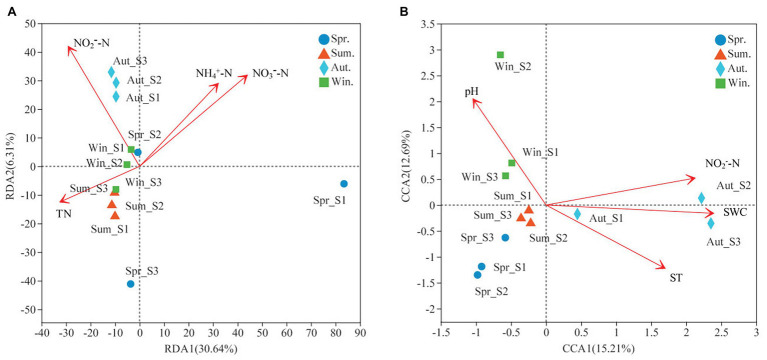
RDA or CCA of the soil bacterial (A) and fungal (B) community structure and environmental variables at four seasons. Only the environmental variables which were significantly correlated with RDA1, or CCA1 were shown in figures.